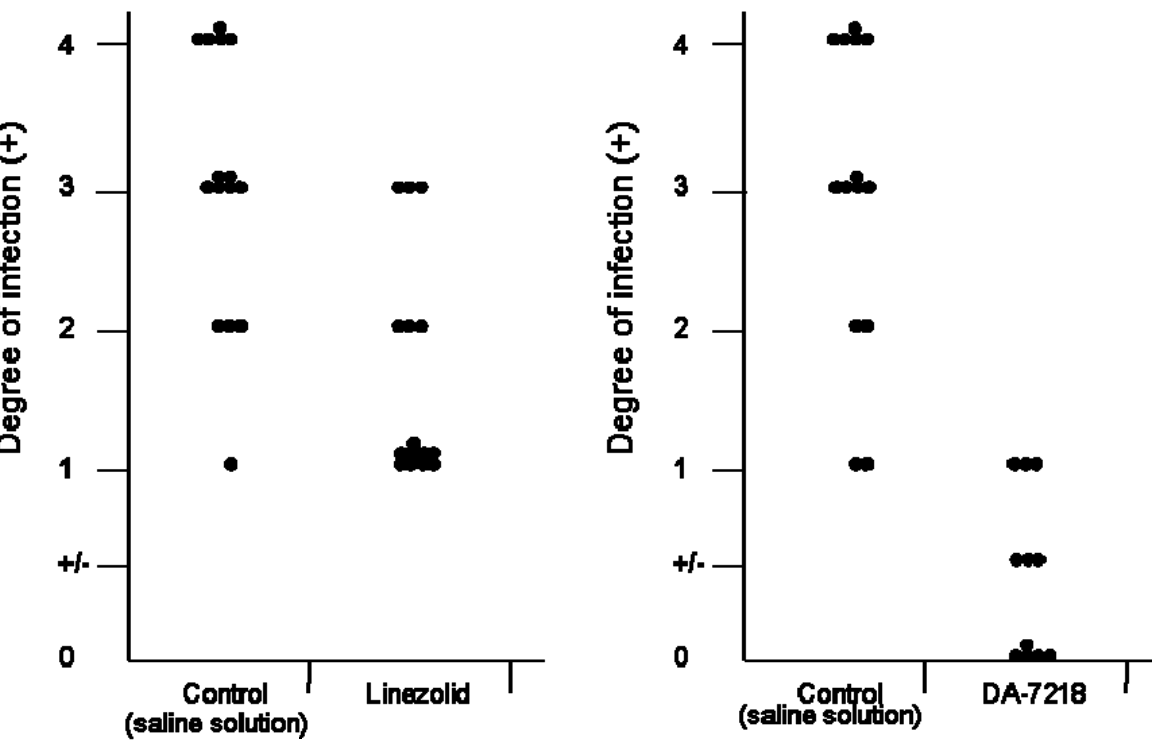
Figure 5. Comparison of the in vivo effects of linezolid and DA-7218. In both cases the antimicrobials were applied subcutaneously at 25 mg/kg, Left, linezolid; right, DA-7218. Each point represents one